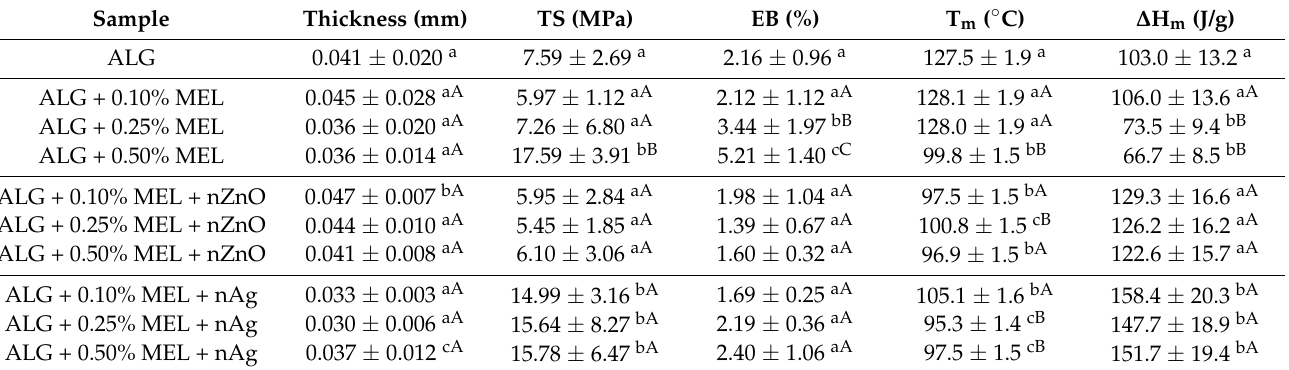
Table 3. Thickness, mechanical, and thermal characteristics of unmodified and modified alginate